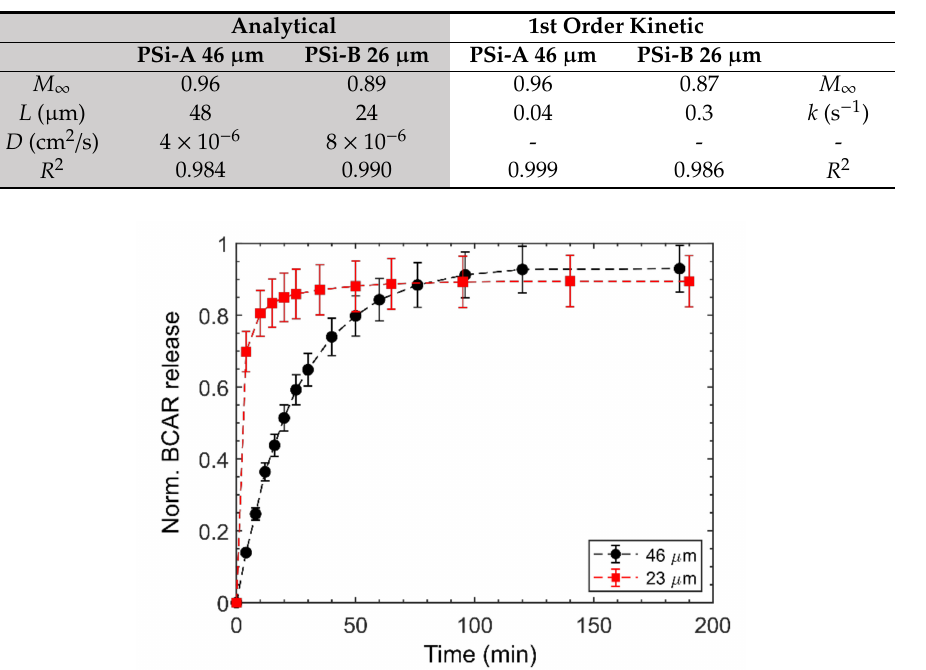
Table 3. Example of releases from both PSi-A and PSi-B samples fitted with the (left) analytical mode (Equation (7)) and (right) the 1st order kinetic (Equation (13)). M ∞ is the normalized release amount of BCAR, L is the pore length, D is the di ff usion coe ffi cient, k is the time constant.